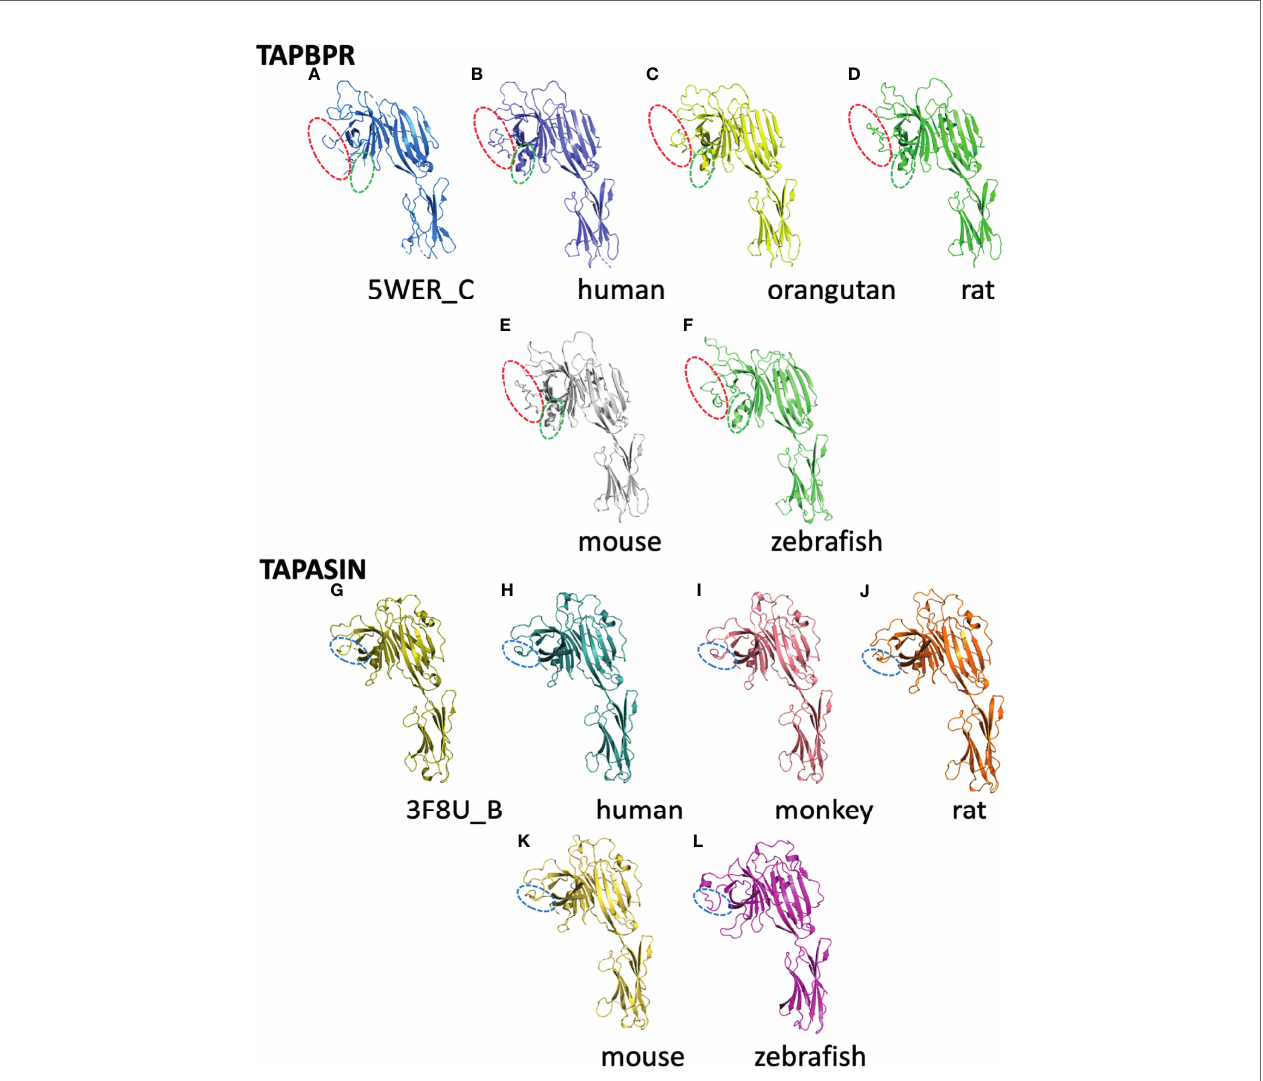
FIGURE 5 | Structures predicted by AlphaFold2 preserve features of experimentally derived structures. The AlphaFold2 Protein Structure Database (https:// alphafold.ebi.ac.uk) was queried for TAPBPL (alternate designation for TAPBPR) or TAPBP (for tapasin) and the resulting structural models were superposed on experimentally determined structures for TAPBPR (5WER chain C) (A) and tapasin (3F8U chain B) (G) as indicated. (B) represents the predicted human TAPBPR. (C) Pongo abelii (Sumatran orangutan). (D) Rattus norvegicus. (E) Mus musculus. (F) Danio rerio. Panels (G – L) represent tapasin (TAPBP) structure (3F8U chain B) (G) , and models of human (H) , Chlorocebus aethiops (I) , Rattus novegicus (J) , Mus musculus (K) , and Danio rerio (L) . As described in the text, loops that were not modeled based on X-ray data but were modeled by AlphaFold2 are indicated by dashed